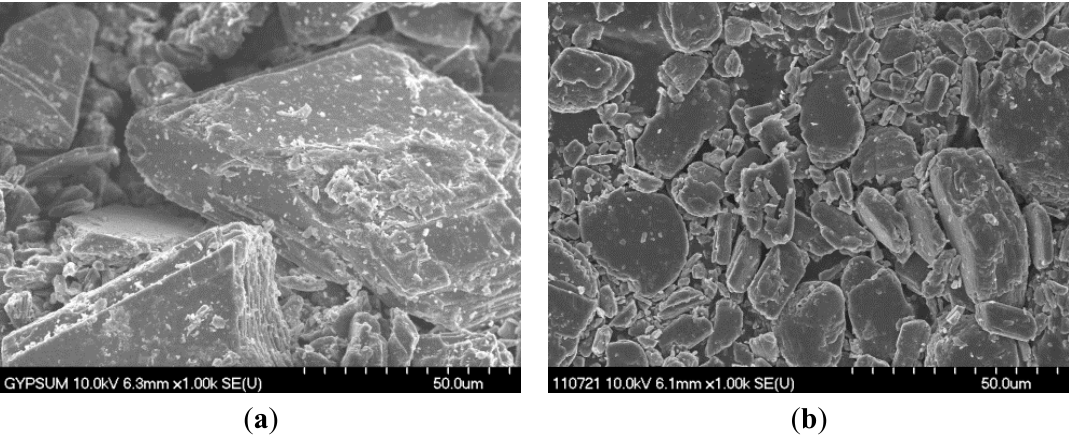
Figure 3. Scanning Electron Microscope (SEM) images of gypsum: ( a ) Raw gypsum with tiny particles (<2 µm) on the surface of larger particles; ( b ) Gypsum after circulation for 16 min through the MBG: The tiny particles disappeared and the large particles were broken into smaller